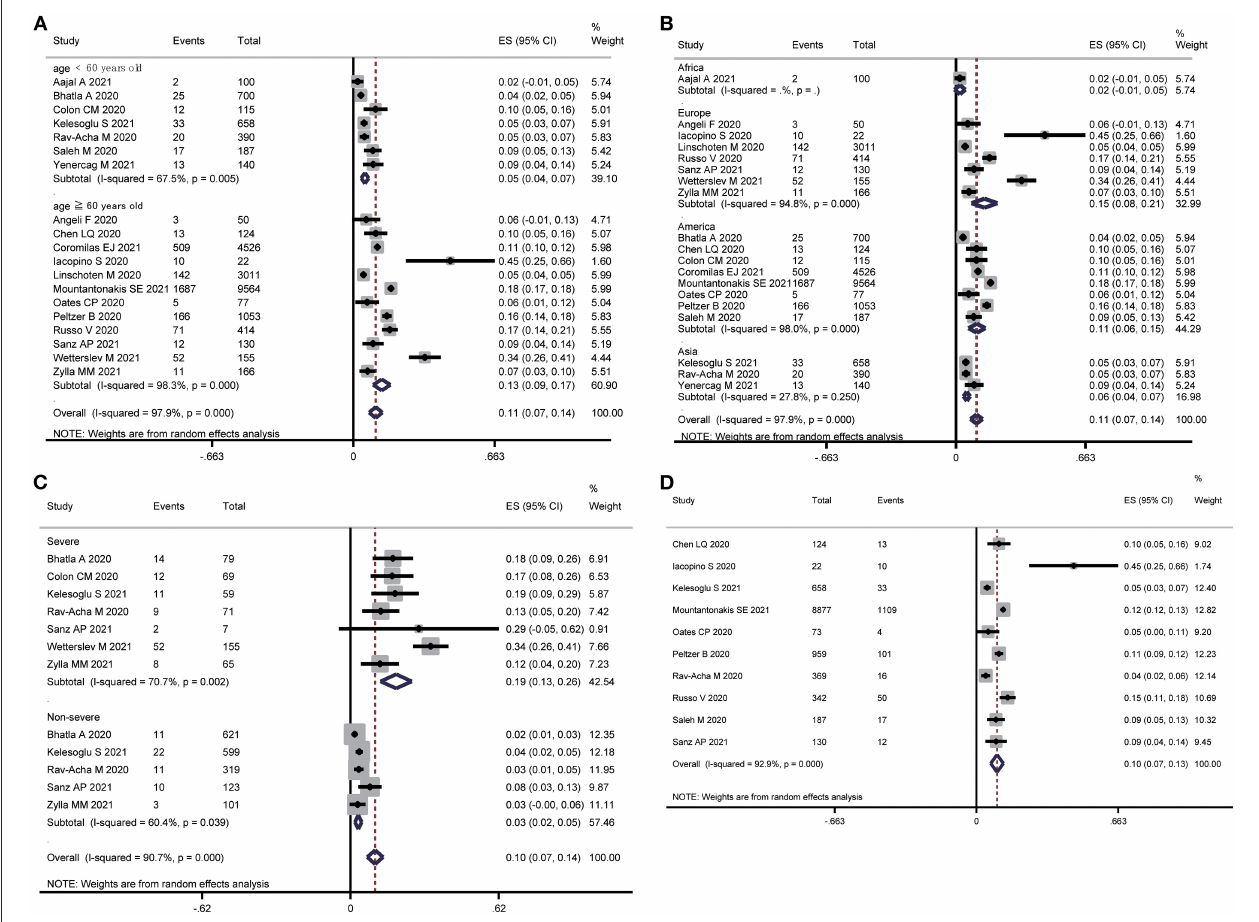
FIGURE 3 | Subgroup analysis of the prevalence of atrial fibrillation in patients with COVID-19. (A) Age subgroup. (B) Region subgroup. (C) Severity subgroup. (D) New-onset atrial fibrillation subgroup.